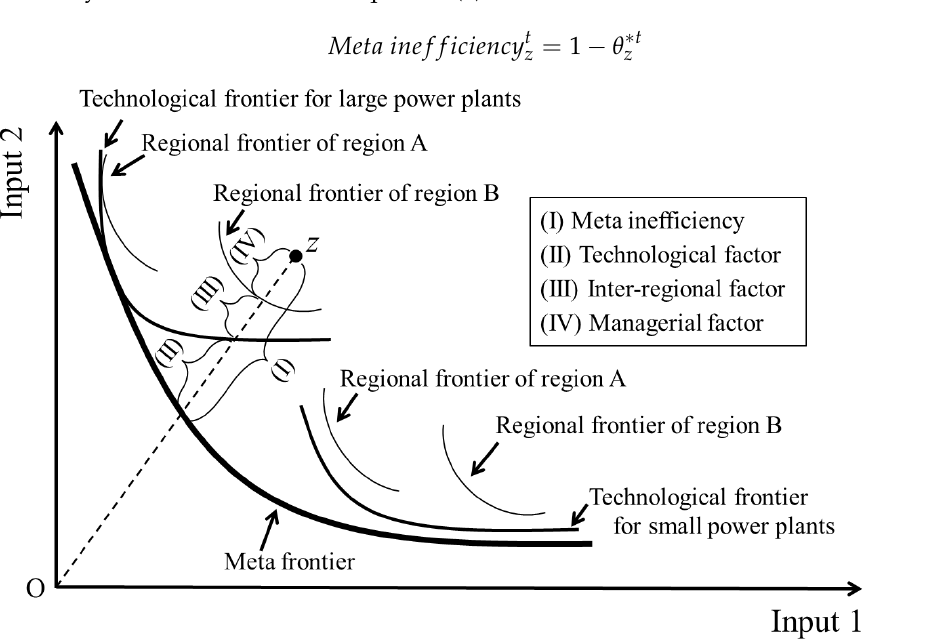
Figure 1. Conceptual illustration of the MDEA framework proposed in this study.